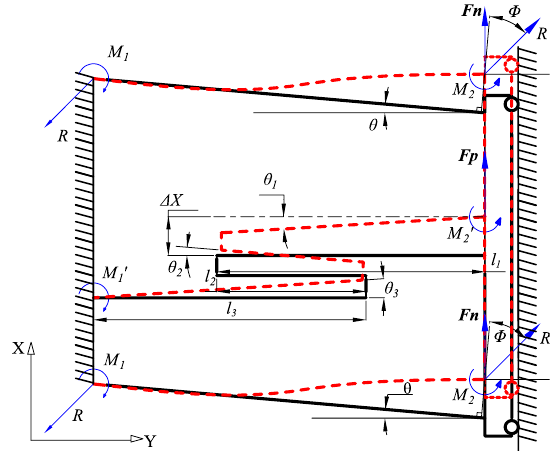
Figure 3. Kinematic model of one-half layer for the CCFM in top